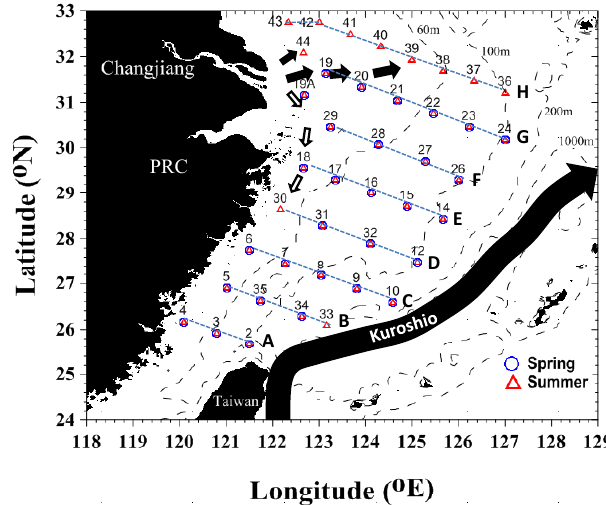
Fig. 1. Bathymetric map showing the sampling stations during the cruises in spring (circles) and summer (triangles) of 2009. Superim- posed is a schematic representation of the Kuroshio Current and the seasonal dispersion of the Changjiang discharge, in which empty and solid arrows represent the conditions during dry and flood sea- sons,